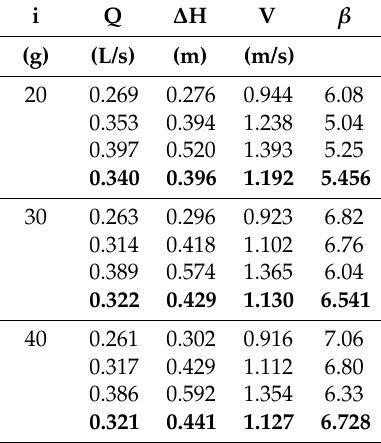
Table 3. Values of the head losses, discharges, velocities and β coefficients (the values in bold type are the averages) for progressive clogging rates with fine sand.